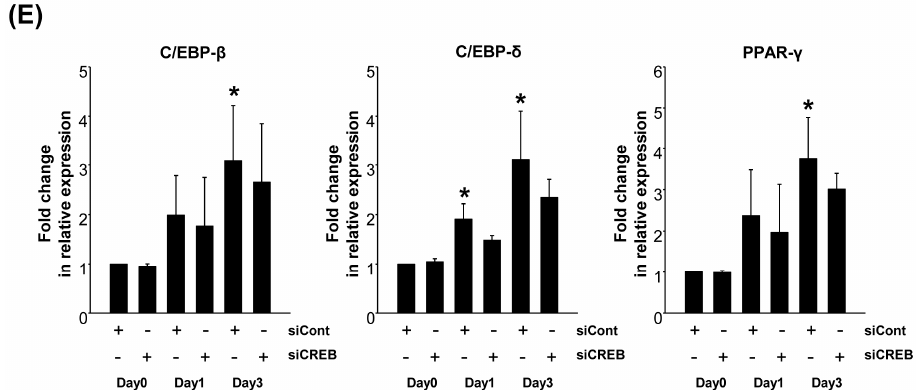
Figure 3. Involvement of CREB-dependent GRP-R in adipogenesis. ( A ) Localization of putative CREs within the ~5 kb fragment of the 5 ′ –flanking region of the mouse GRP-R gene. Putative CRE sites were defined by the core sequence 5 ′ -TGACGTCA-3 ′ . ( B ) The sonicated cell lysate from differentiated 3T3-L1 cells was immunoprecipitated with antibodies against control IgG or CREB. A sonicated cell lysate was used as an input control. The two putative CRE binding sites (CRE1, − 4737– − 4729 and CRE2, − 506– − 499) were amplified by PCR using specific primers to the CRE1 or CRE2 sequence. ( C ) The sonicated cell lysate from undifferentiated or differentiated 3T3-L1 cells were cultured as described and subjected to ChIP assay. IgG or CREB antibody was used to precipitate sonicated chromatin. ( D ) 3T3-L1 cells were transfected with negative control siRNA or CREB siRNA for 72 h. The expression of CREB or GRP-R protein was confirmed by Western blot assay using CREB or GRP-R antibodies, respectively. (E) Control siRNA or CREB siRNA-transfected 3T3-L1 cells were incubated with DMI for indicated days. Total RNA was purified and analyzed by real-time PCR using specific primers for C/EBP- β , C/EBP- δ , or PPAR- γ . * p < 0.05 compared to Day 0.